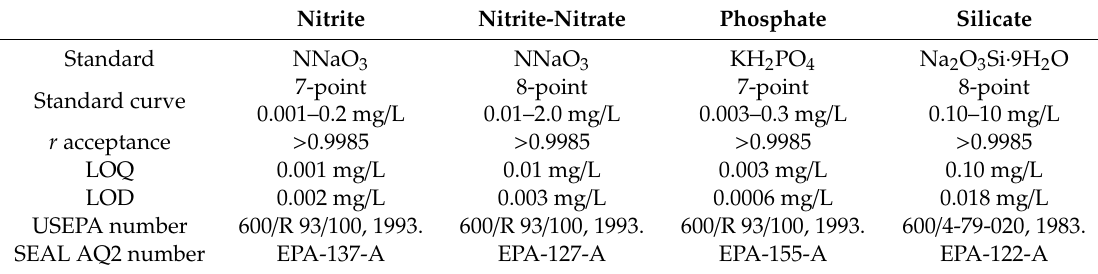
Table 4. Nutrient analysis standard and test methods. Prepare standards to construct a seven or 8-point calibration curve per the test methods. Ensure each standard curve passes the acceptance criteria of r, limit of detection, and quantification limit. The standard information is listed in Appendix Table